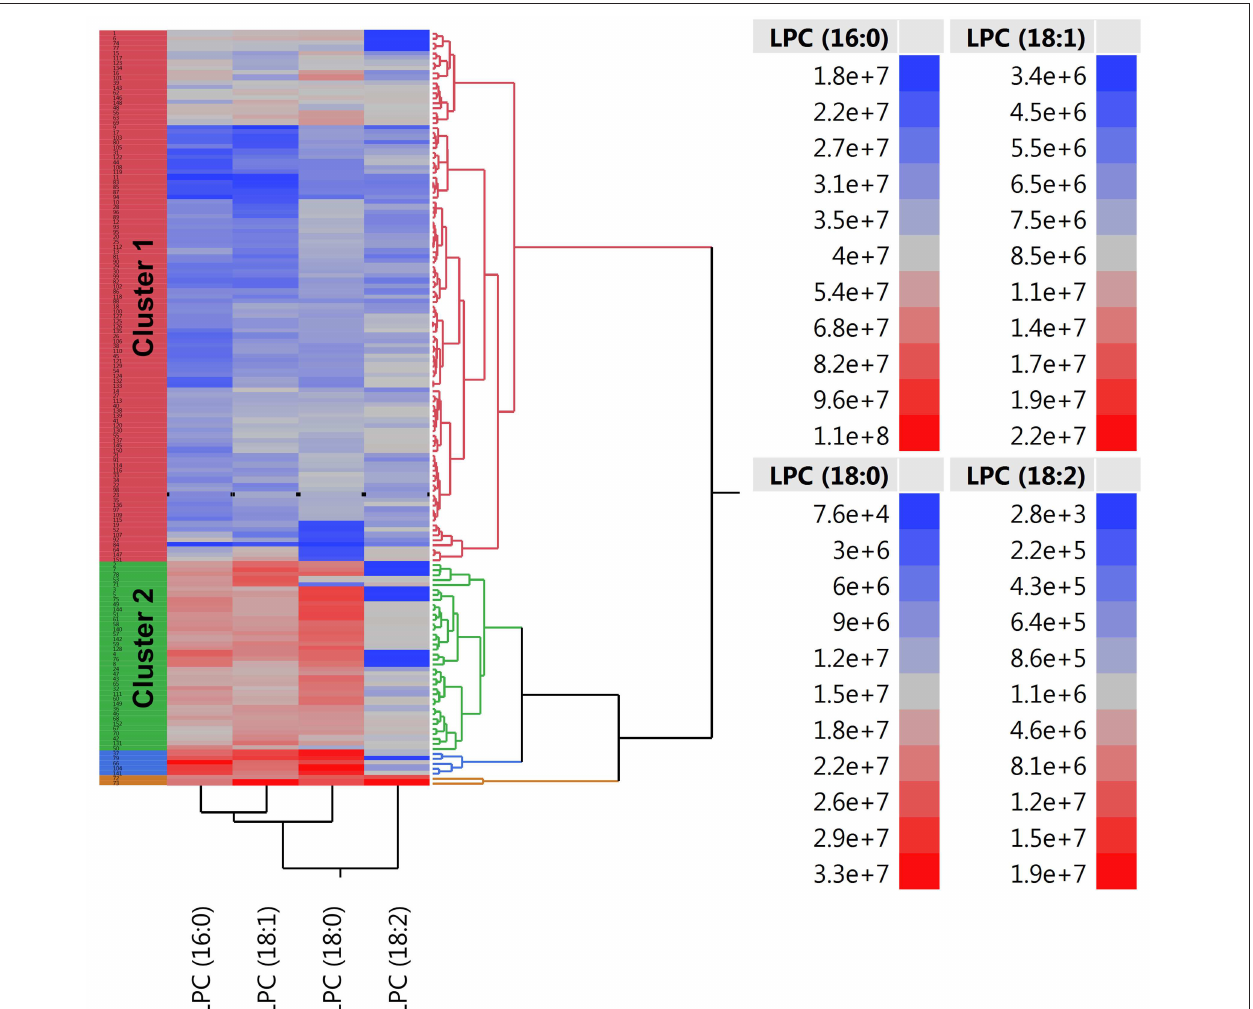
Frontiers in Molecular Biosciences |